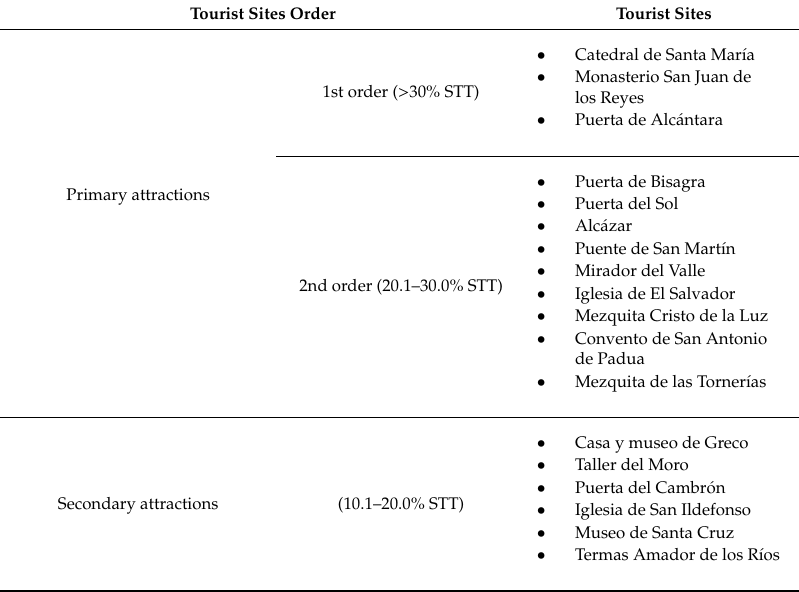
Table 5. Classification of the tourist sites according to the percentage of STTs per street segment where they are